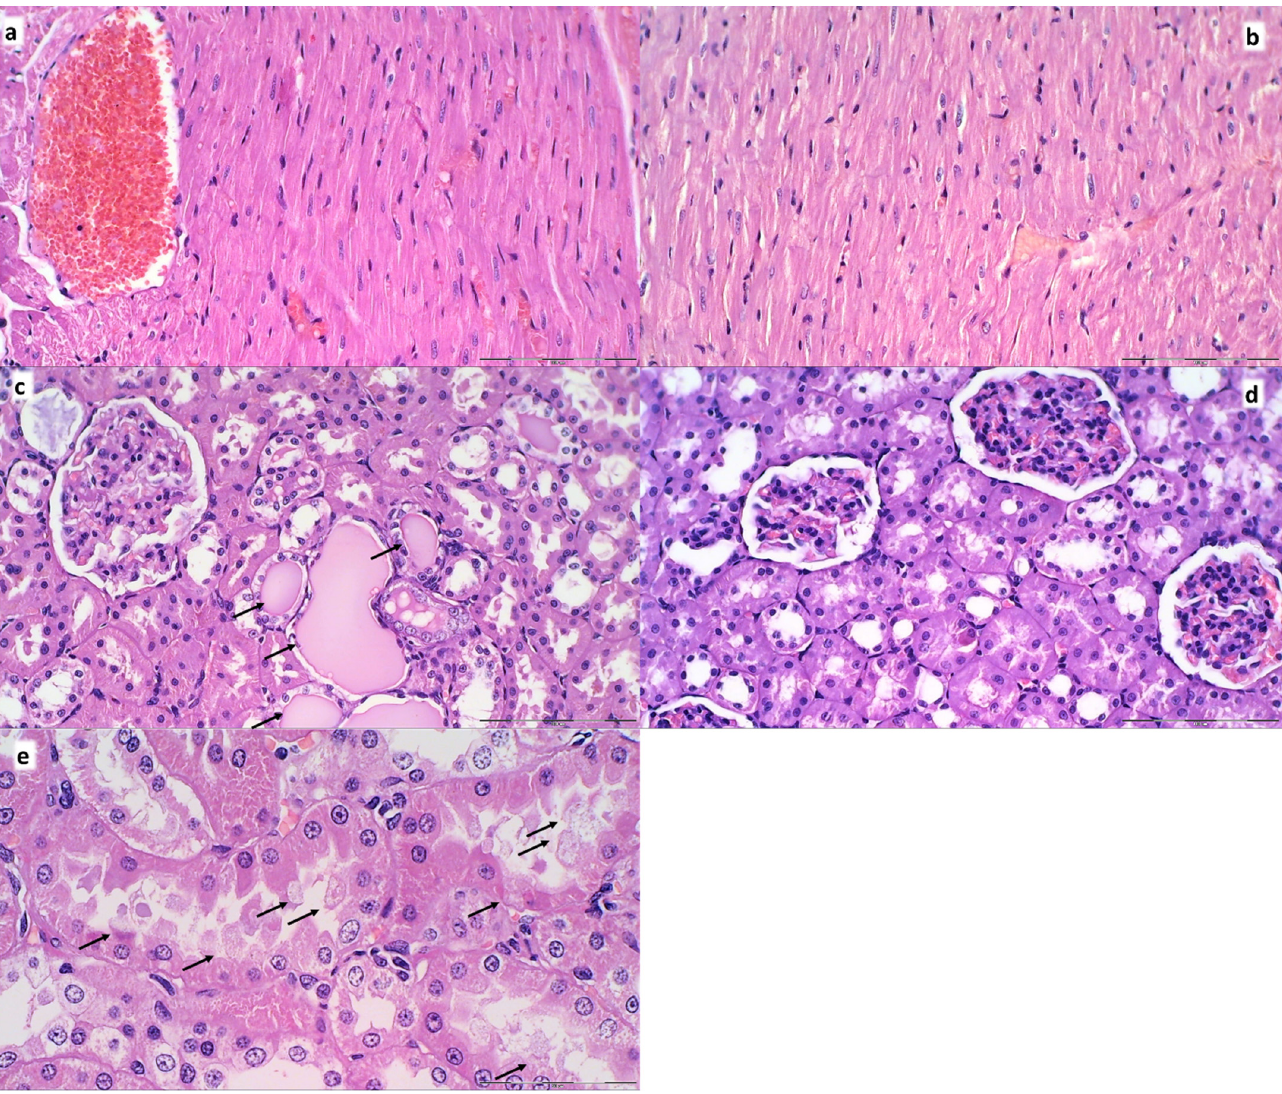
Figure 16. Illustrative microscopic presentation of the heart ( a ) (control), ( b ) (BPC 157)) and kidney ( c , e ) (control), ( d ) (BPC 157), (HE staining). Presentation at the 20 min ligation-time, 5 min after saline ( a , c ) or BPC 157 ( b , d ) intragastric application. Heart. ( a ) Control rats with marked congestion in the heart tissue, within myocardium and large coronary branches; ( b ) no vascular congestion in BPC 157 rats. Kidney. ( c , e ). Hyaline tubular cylinders ( c ), cell degeneration of proximal and distal tubule with cytoplasmic vacuolization in controls ( e ); ( d ) BPC 157 rats showed no pathological changes. Magnification ×200 (( a – d ) scale bar 100 µm); ×400 (( e ) scale bar 50 µm).